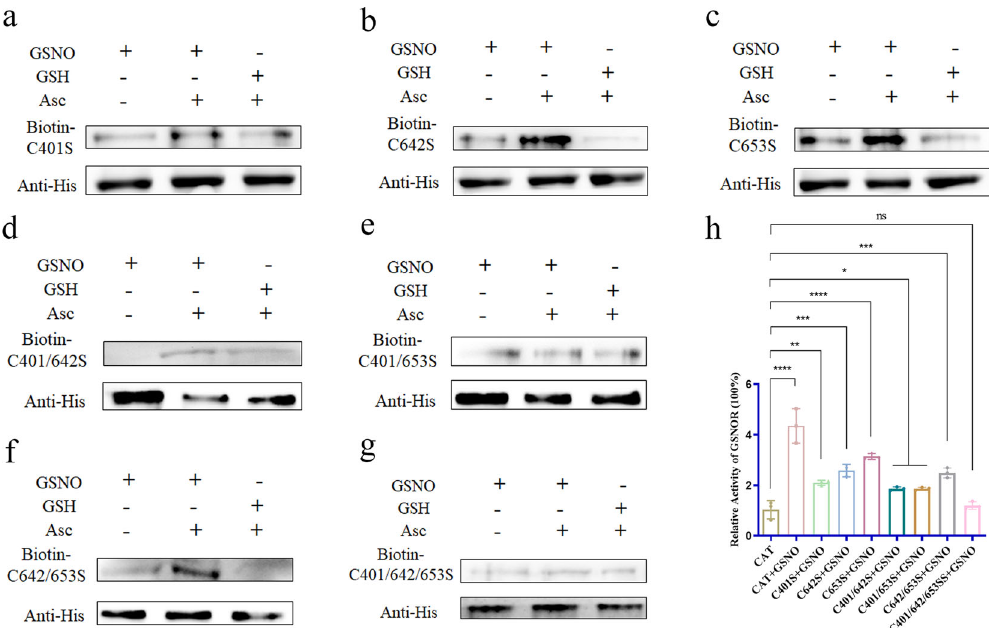
Fig. 6 Effects of GSNO treatment on CAT S-nitrosylation and activity. The recombinant CAT protein mutants C401S, C642S, C653S, C401/642S, C401/ 653S, C642/653S, and C401/642/653S were treated with GSH (negative control for GSNO) and GSNO. Then the protein is subjected to the biotin switch method to determine S-nitrosylation. The samples without Asc as a negative control. Proteins sample were separated via SDS – PAGE and analyzed by immunoblotting using an anti-biotin antibody and the His tag antibody. a – c C401S, C642S, and C653S are recombinant CAT protein mutants in which the cysteine residues at positions 401, 642, and 653 were changed to serine (Ser). d – f C401/642S, C401/653S, and C642/653S are recombinant CAT protein mutants in which the cysteine residues at positions 401/642, 401/653, and 642/653 were changed to serine (Ser). g C401/642/653S is a recombinant CAT protein mutant in which the cysteine residues at positions 401/642/653 were changed to serine (Ser). h The CAT activity of the different CAT proteins was determined as the rate of H 2 O 2 decomposition per minute by measuring the absorbance at 240 nm with and without GSNO treatment. Data are presented as the mean ± SD of data from three independent experiments (ns not signi fi cant; * P < 0.05, ** P < 0.01, *** P < 0.001; **** P < 0.0001 by one-way